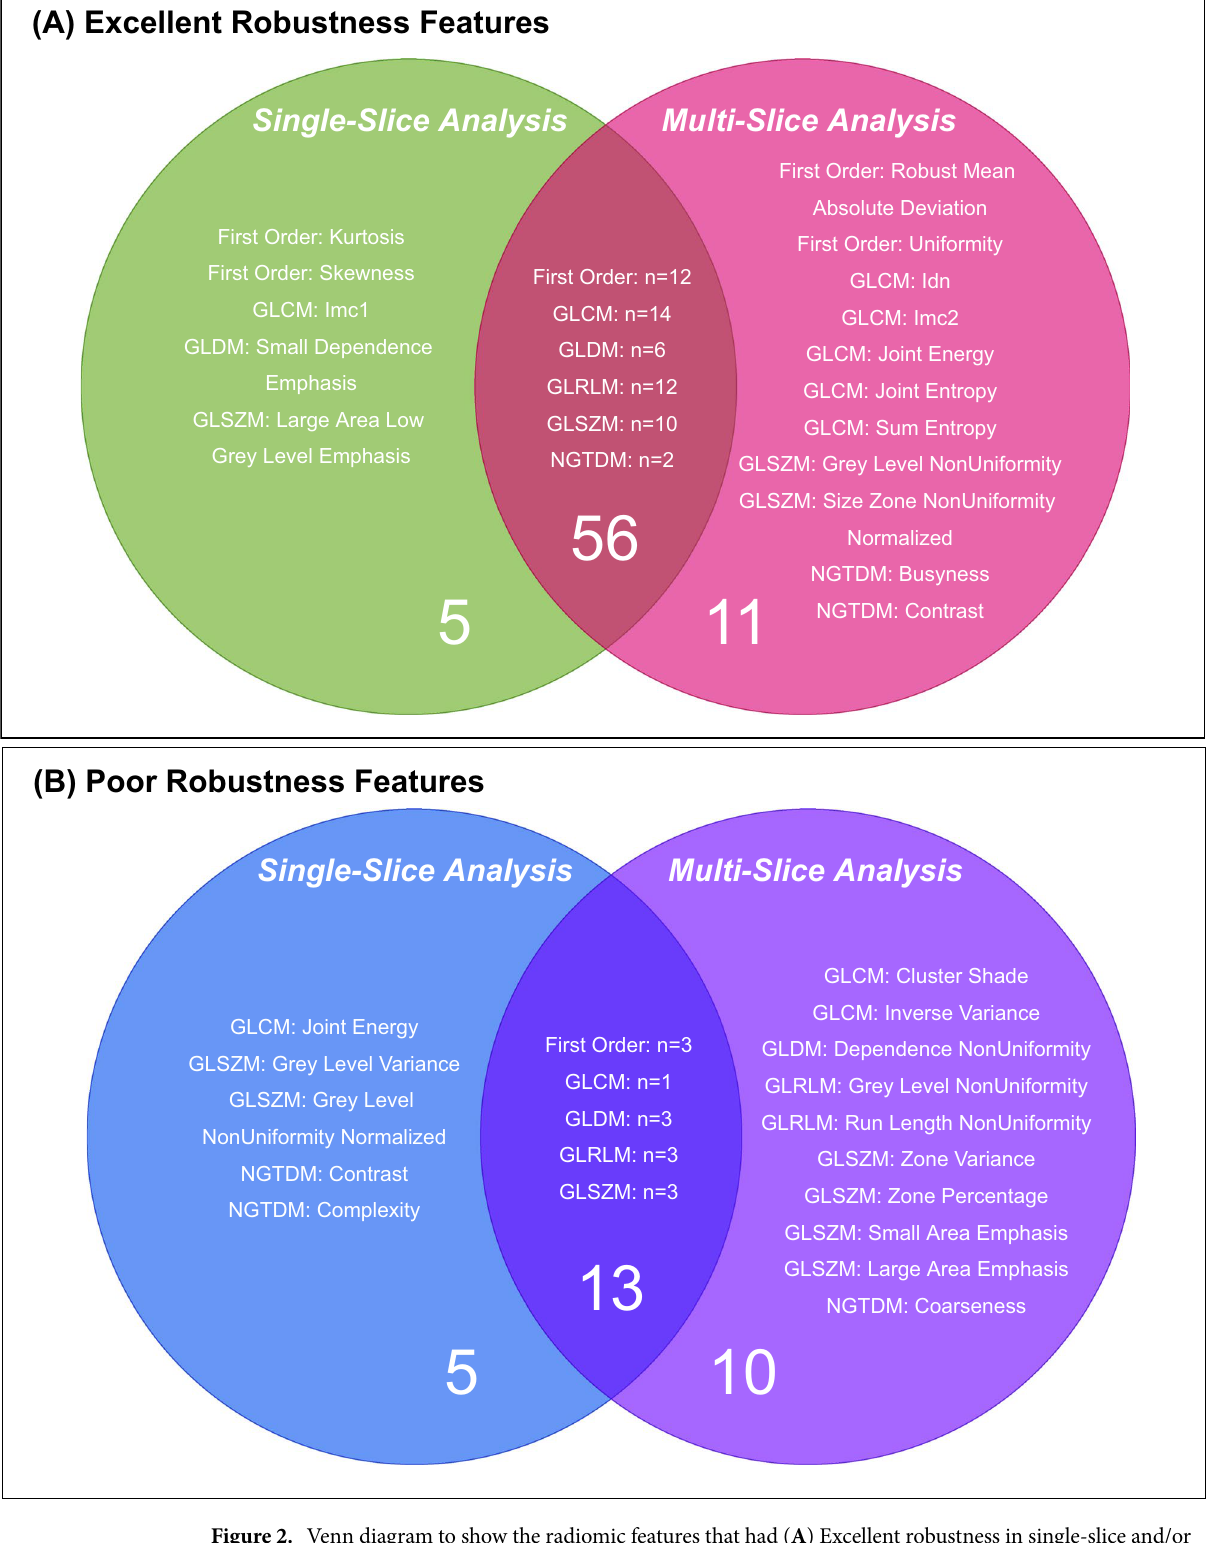
Figure 2. Venn diagram to show the radiomic features that had ( A ) Excellent robustness in single-slice and/or multi-slice analysis and, ( B ) Poor robustness in single-slice and/or multi-slice